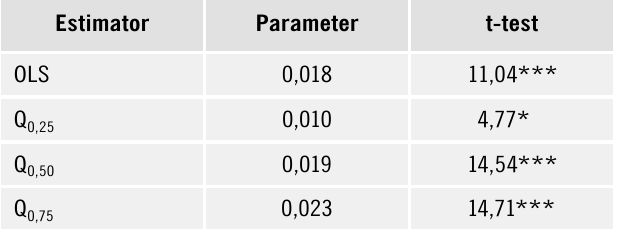
Table A3.2. OLS and quantile estimation of simple regression of alternative SDI against GP _ all